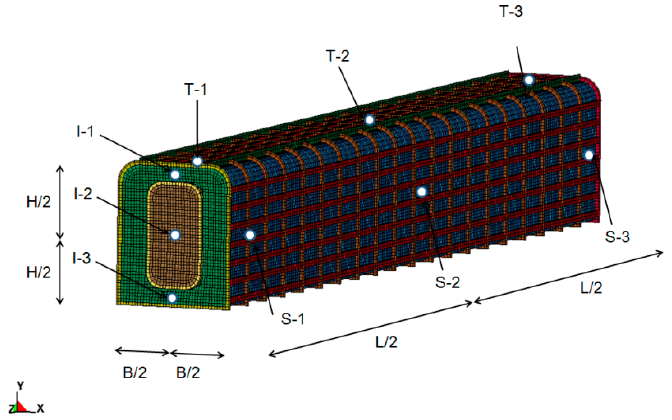
Figure 4. The distribution of testing points.